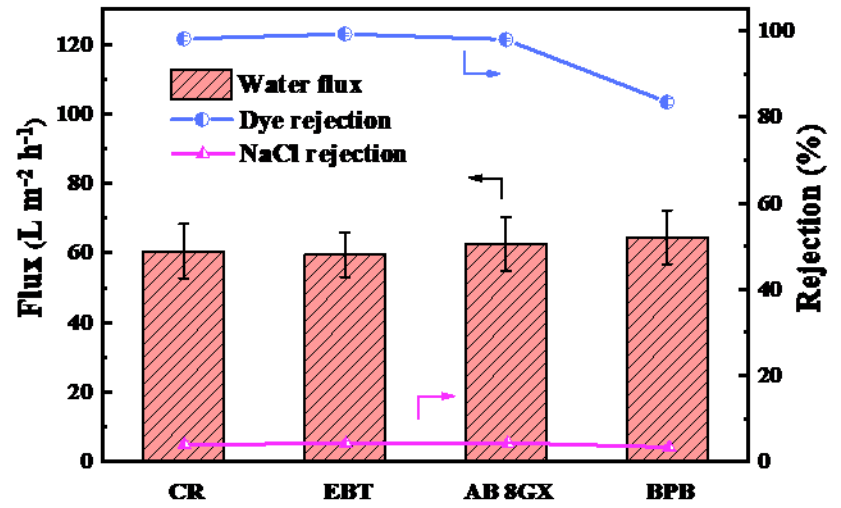
Figure 7. Separation performance of dye/salt composite system.